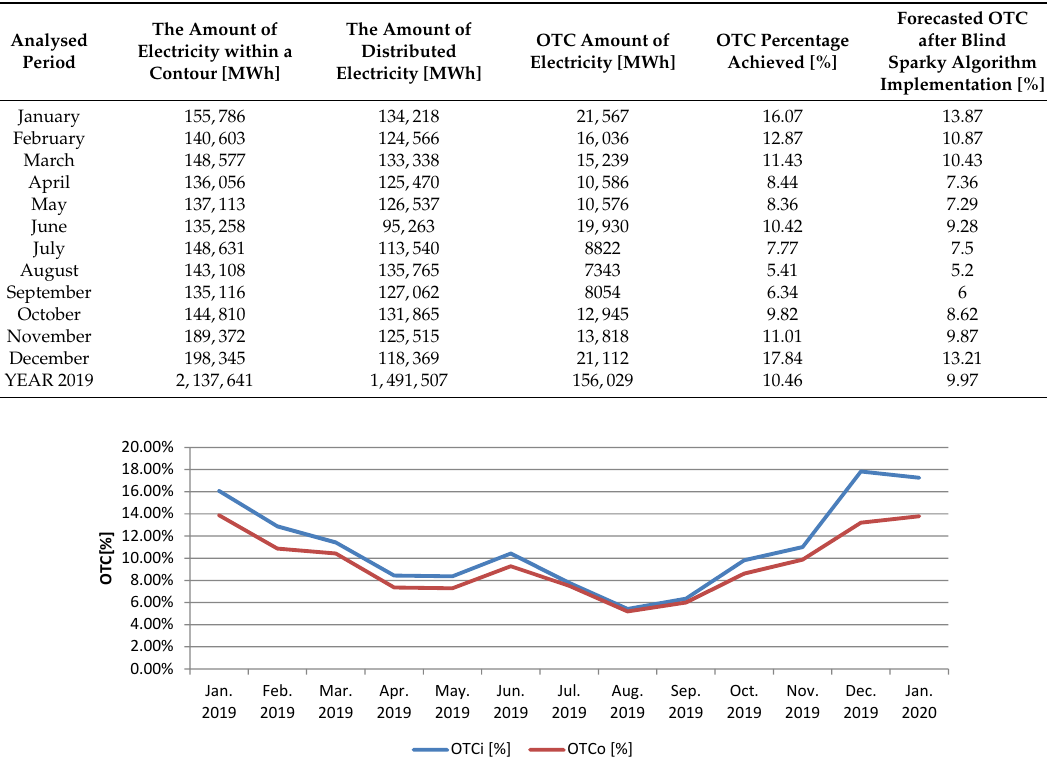
Figure 8. Measured and optimized OTC evolution for whole sector integrating analysed sector (OTCi—initial/measured values; OTCo—optimized